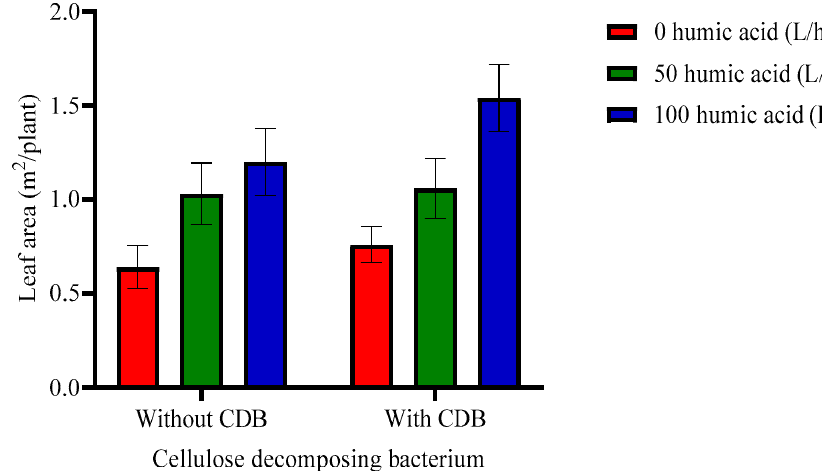
Figure 1. Interaction effects of humic acid levels with and without cellulose-decomposing bacterium on the leaf area of squash plant in 2021 planting season. Bars indicate ± standard error, and error bars that are not overlapping each other indicate that the means are significantly ( p ≤ 0.05) different from each other.